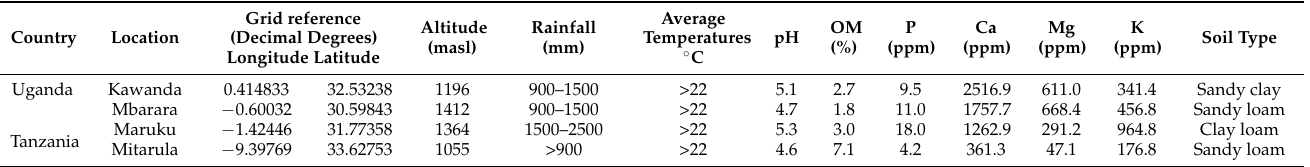
Table 1. Soil analysis and location of sites used for multi-location evaluation of Matooke hybrids (NARITAs) and banana varieties for black Sigatoka resistance evaluation. Country